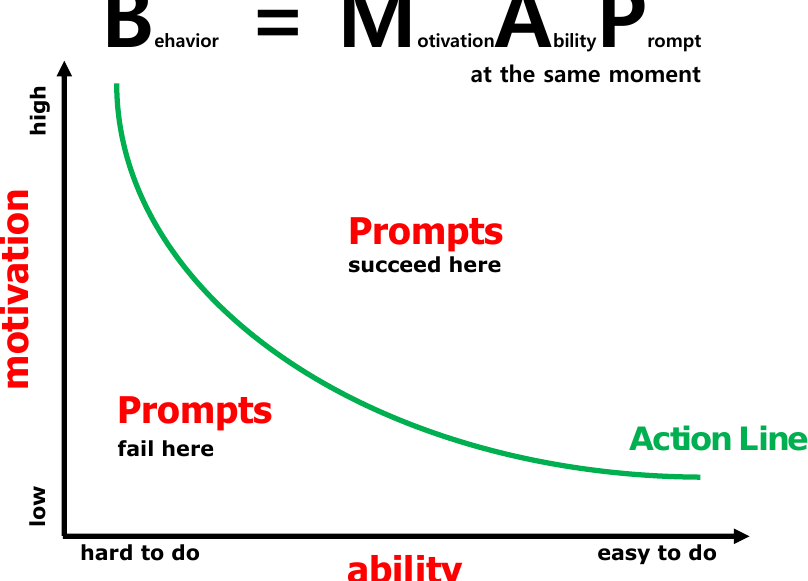
Figure 4. Fogg’s MAP behavior model (motivation, ability, and